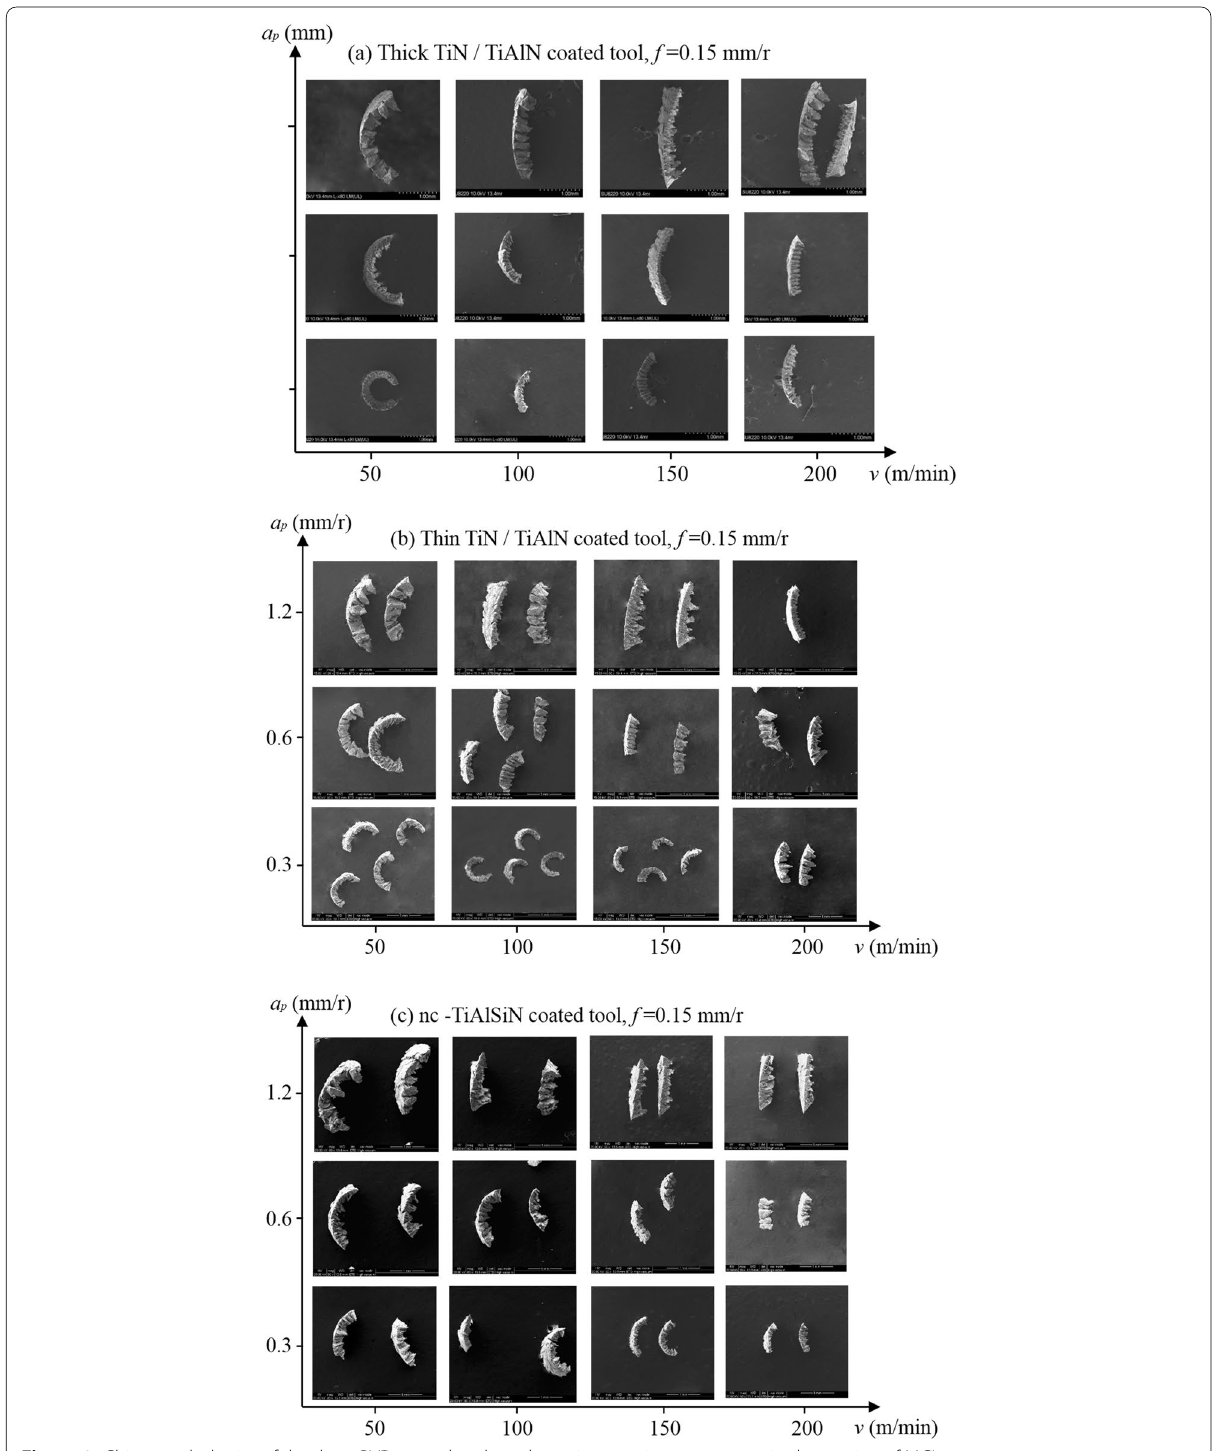
Figure 2 Chip morphologies of the three PVD coated tools under various cutting parameters in dry turning of